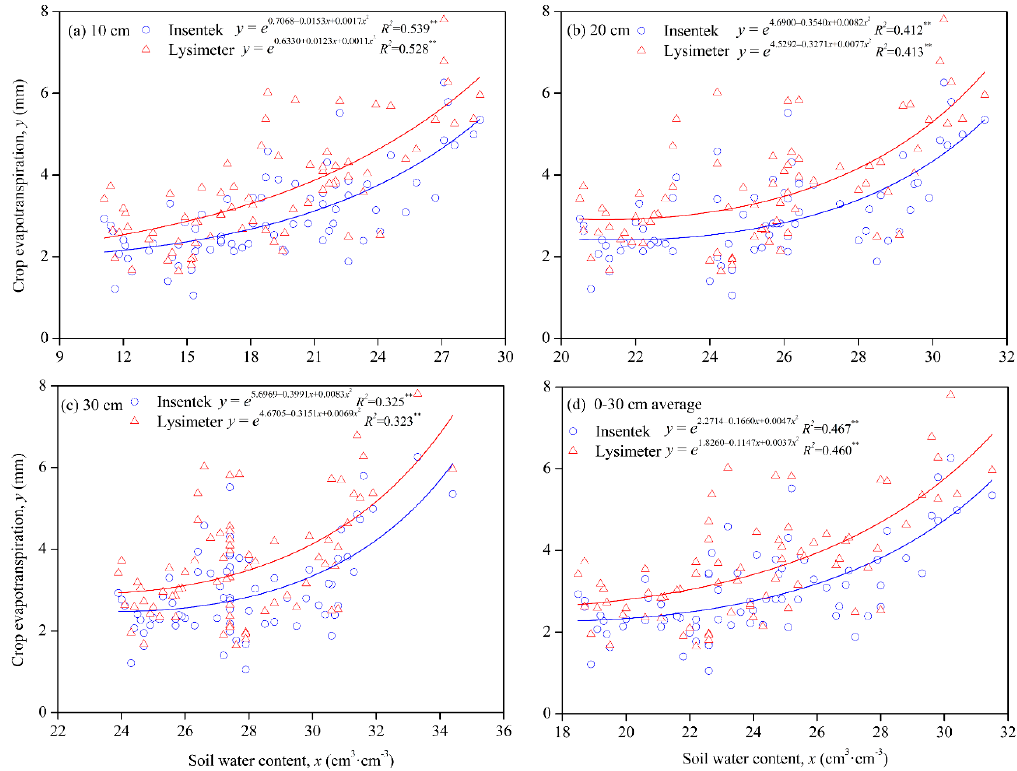
Figure 7. Relationships between crop evapotranspiration (ET c , mm) and soil water content (SWC, cm 3 · cm − 3 ) on clear days at 10 cm interval to a depth of 30 cm. ( a ) ET c related to 10 cm SWC; ( b ) ET c related to 20 cm SWC; ( c ) ET c related to 30 cm SWC; ( d ) ET c related to 0–30 average SWC.